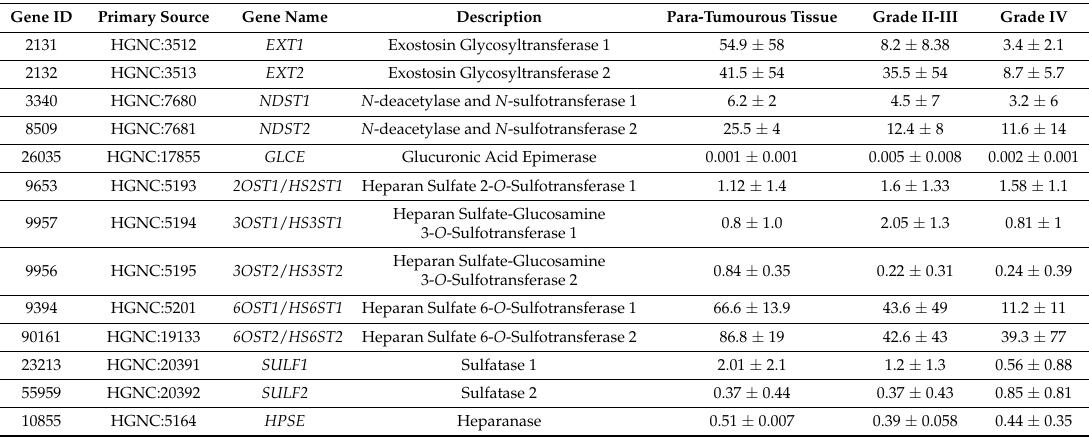
Table 1. Expression levels of HS biosynthesis-involved genes in glioma.